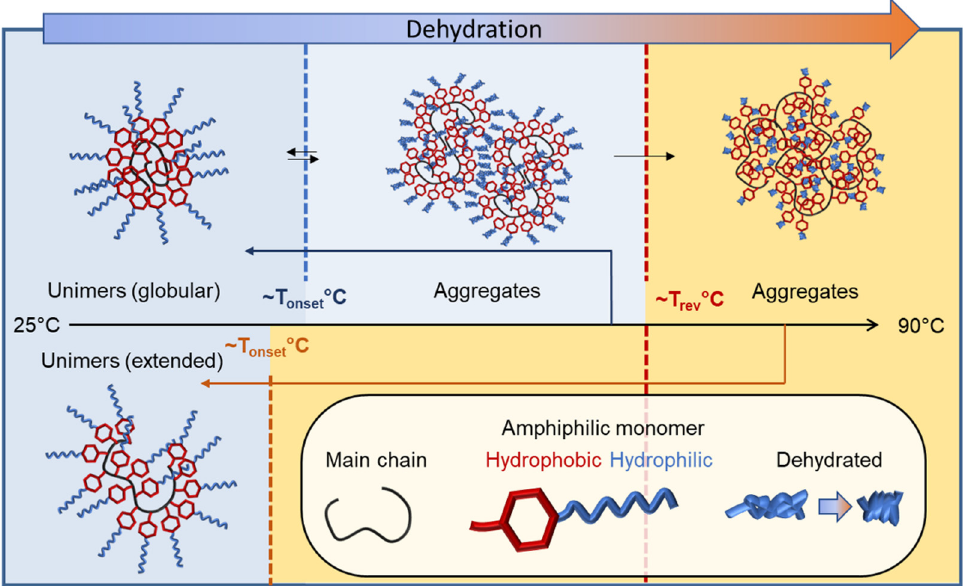
Figure 7. Schematic representation of the self-aggregation process of the amphiphilic homopolymers pEFS8-x below and above T rev.